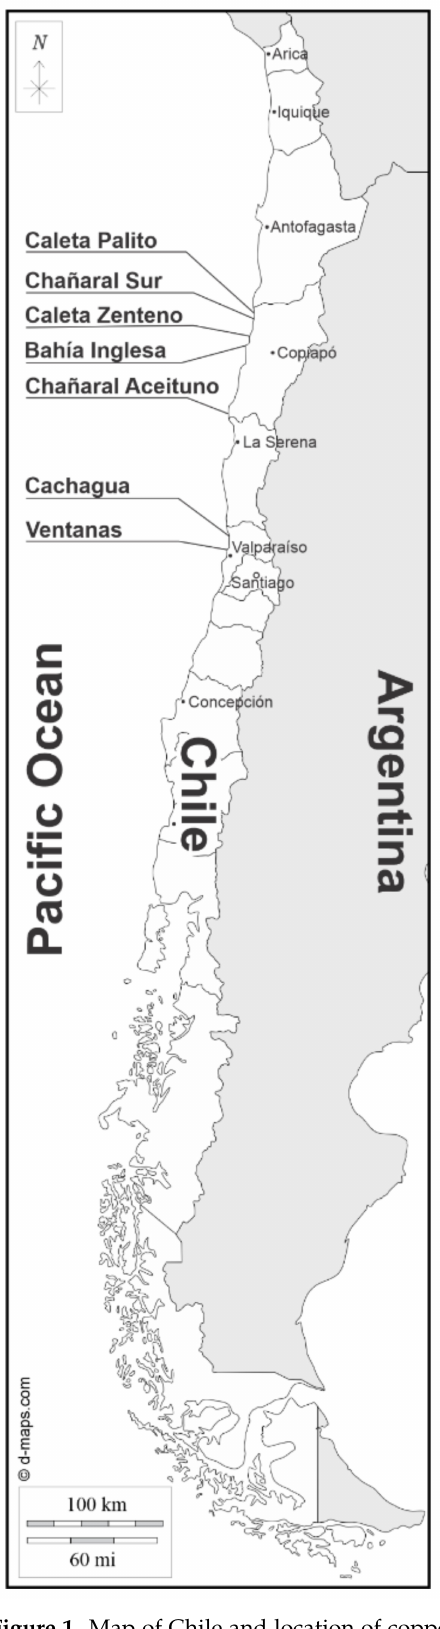
Figure 1. Map of Chile and location of copper-polluted sites in northern Chile, Caleta Palito and Chañaral Sur, control sites in northern Chile, Caleta Zenteno, Bah í a Inglesa and Caleta Aceituno, and control sites in central Chile, Cachagua and